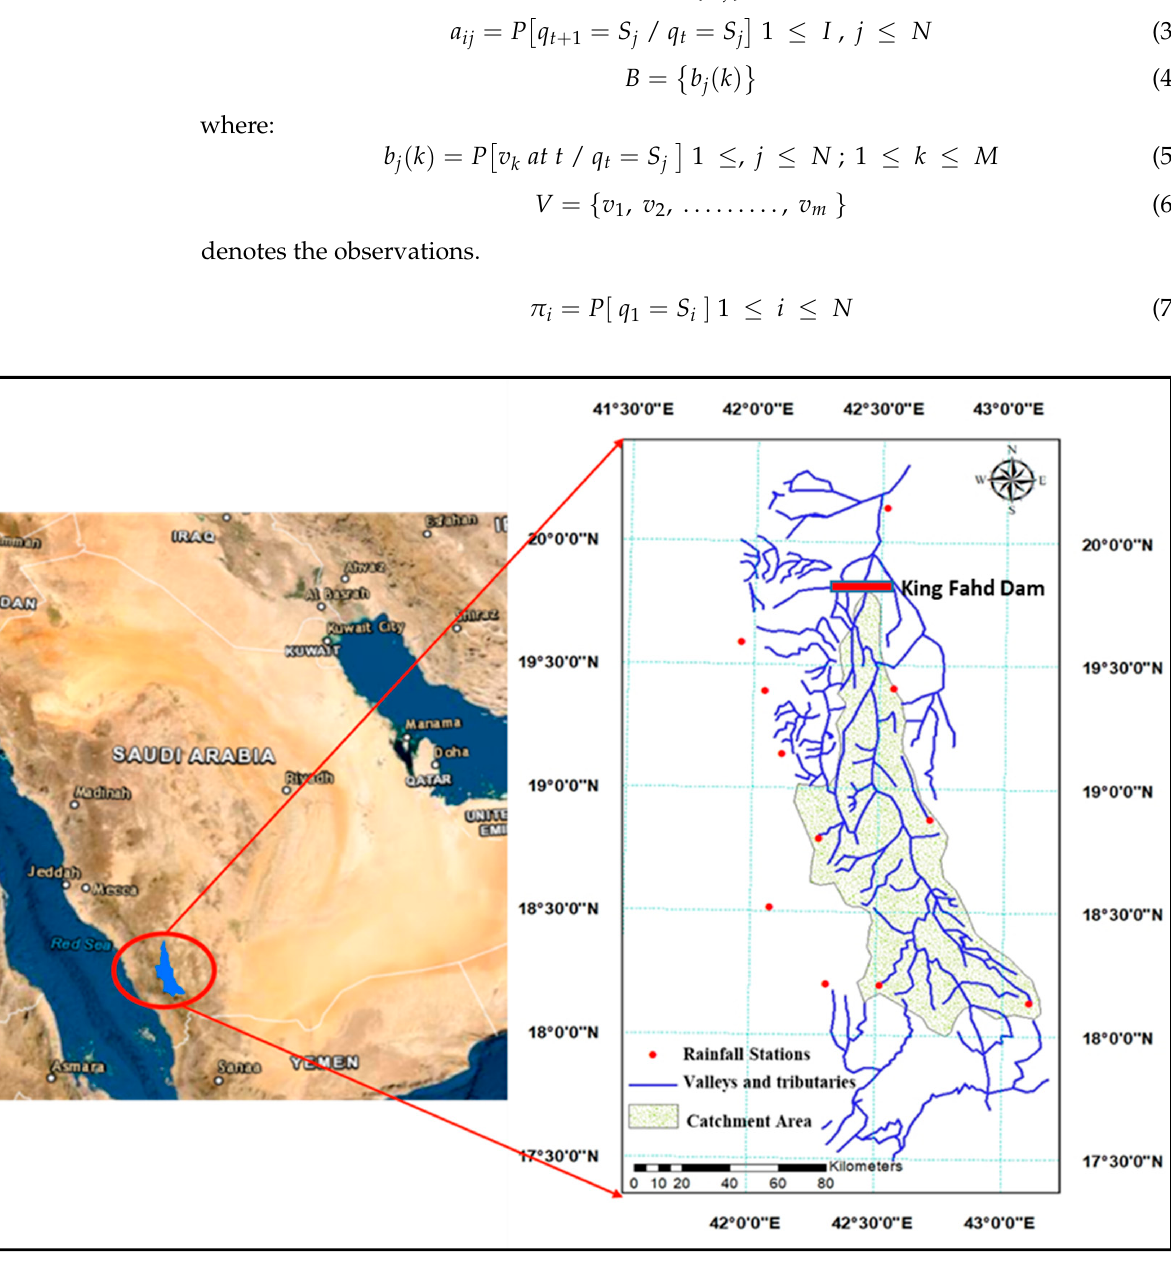
Figure 1. Geographic location of the study area.